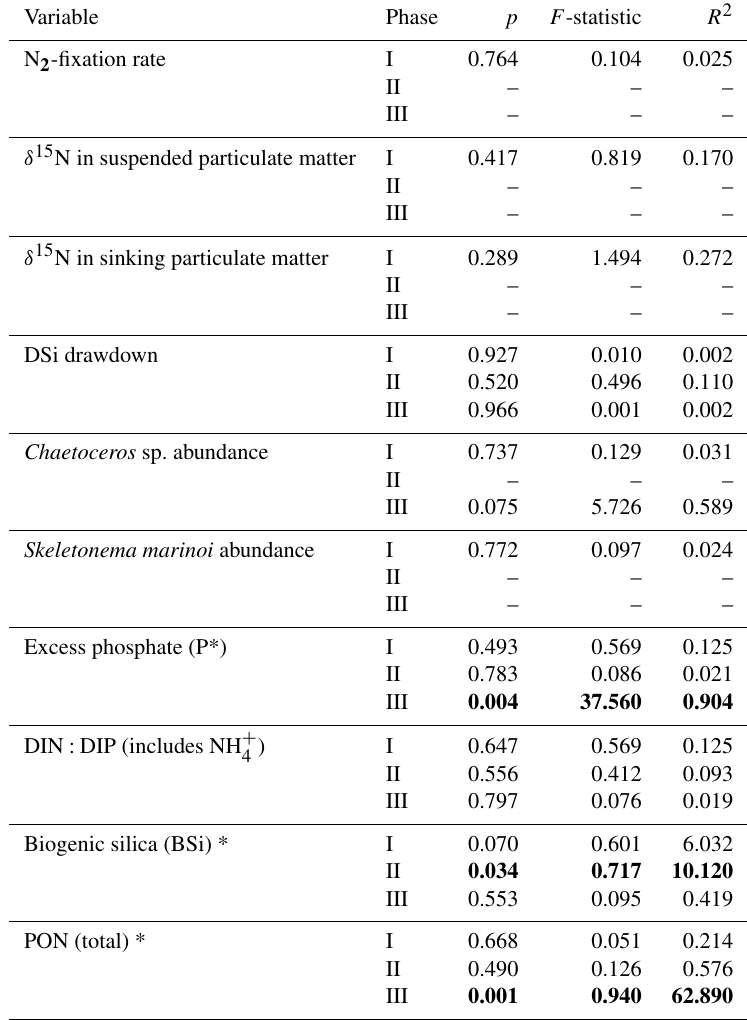
Table 1. Summary of linear regression analyses of f CO 2 and nutrient stoichiometry, dissolved silicate drawdown, abundance of large (>20µm) dominant diatom species present ( Chaetoceros sp., Skeletonema marinoi ), N 2 -fixation rates, stable nitrogen isotope natural abun- dance and particulate biogenic silica and particulate organic nitrogen concentrations. Numbers in bold indicate that the variable had a negative correlation with average f CO 2 . Dashes indicate no regression was completed to avoid any bias in the conclusions because either no data are available, or no complete data set is available. The asterisk (*) indicates data and statistical analyses from Paul et al. (2015). Degrees of freedom, n =